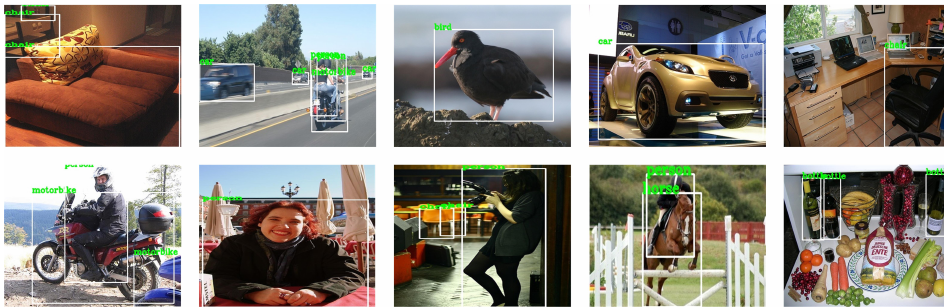
Figure 2. PASCAL VOC2007 datasets.